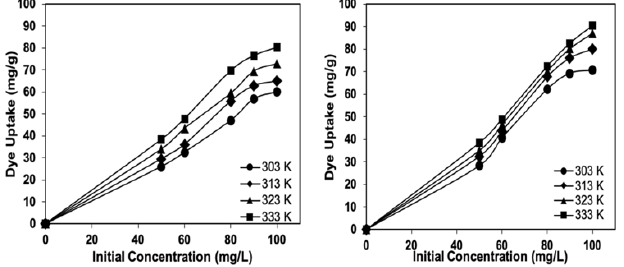
Fig. 6. Concentration vs. malachite green uptake of Mg/Cr (a) and Mg/Cr- (COO) 22 - (b)